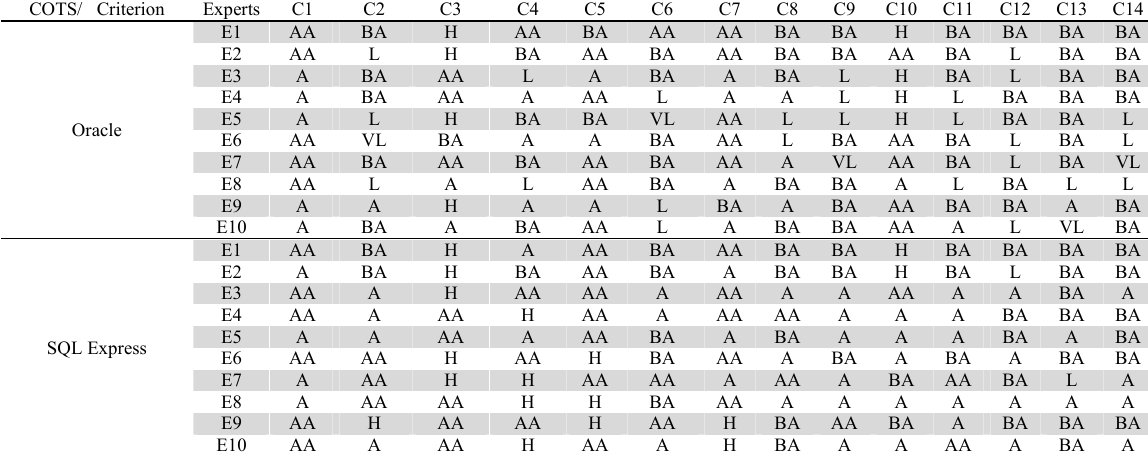
Linguistic assessments for COTS